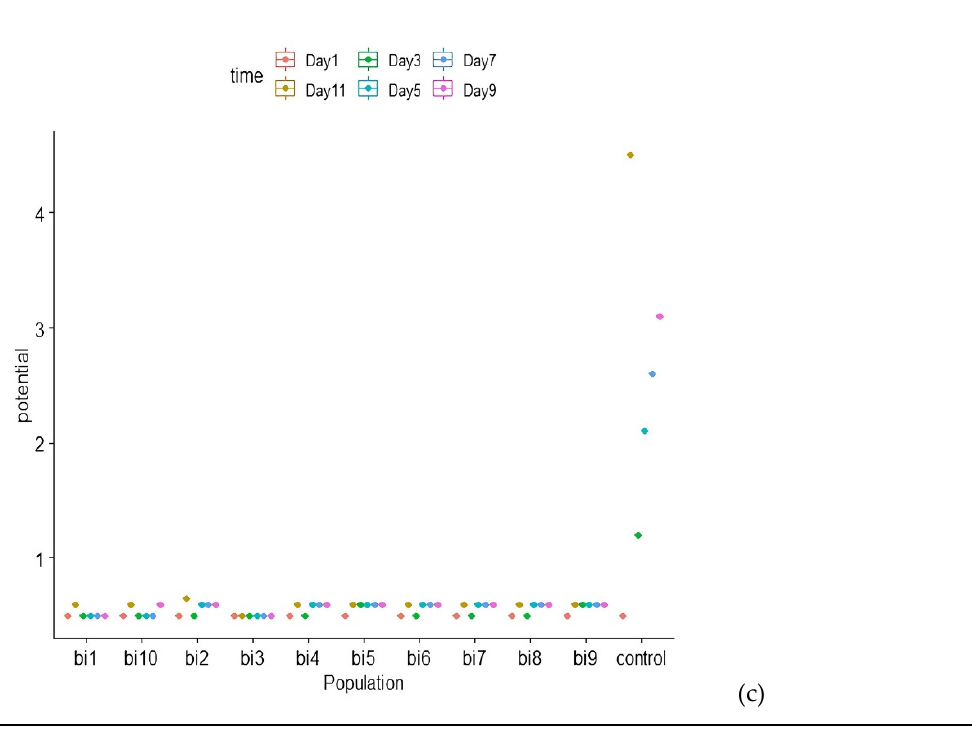
table 3. Inhibition potential of secondary metabolites against ( a ) Alternaria solani , ( b ) Botrytis cinerea , and ( c ) Fusarium oxysporum .